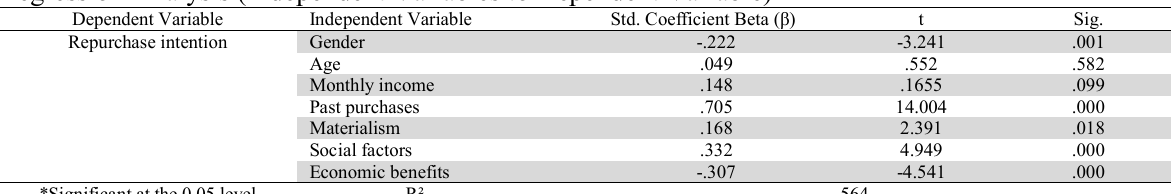
Regression Analysis (Independent Variables to Dependent